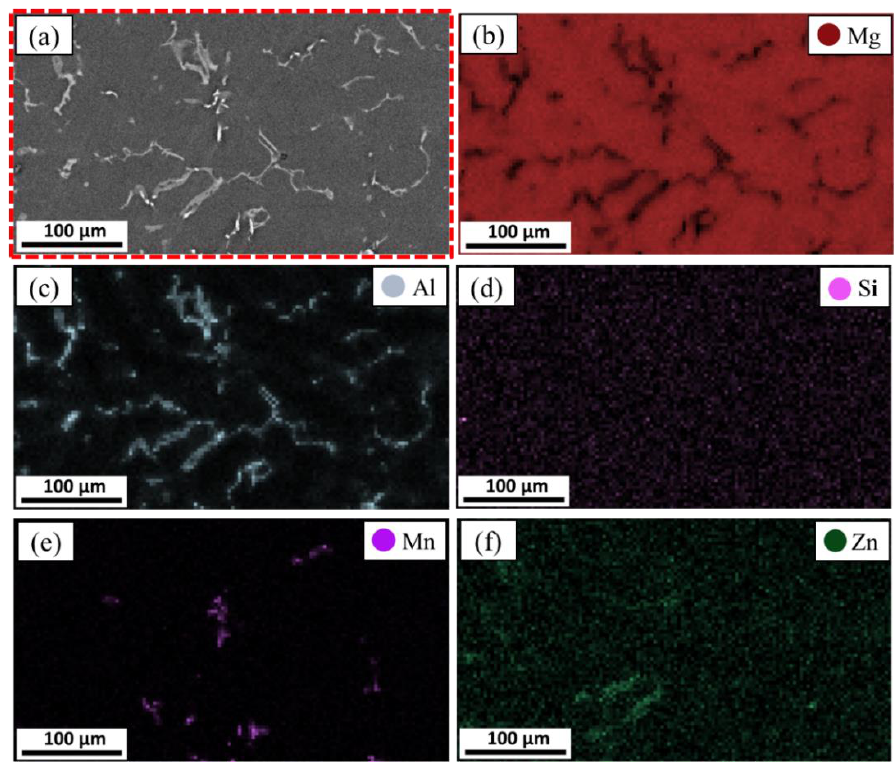
Figure 6. Elemental mapping of the as-cast AZ91 alloy: ( a ) SEM-image shows the selected area microstructure of AZ91 for mapping analysis and the map distribution of main alloying elements: ( b ) Mg, ( c ) Al, ( d ) Si, ( e ) Mn, and ( f )Zn.